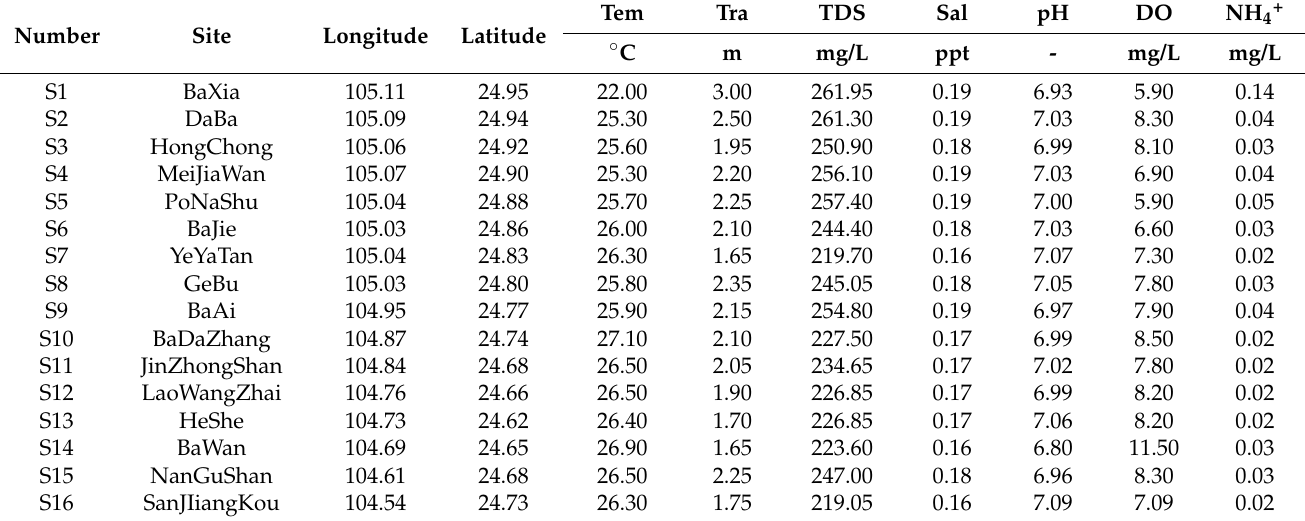
Table 1. Records of latitude, longitude, and environmental factors.